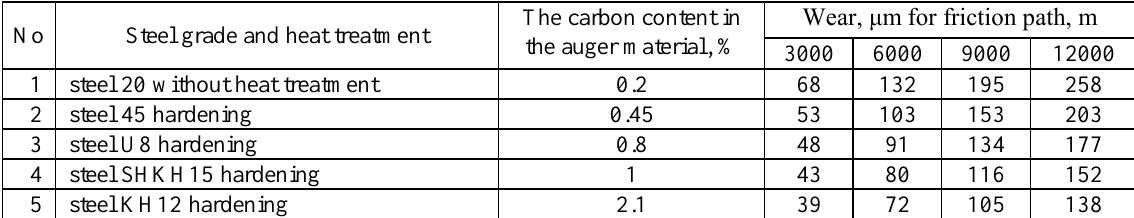
Auger wear values for different values of carbon content in its material and friction path